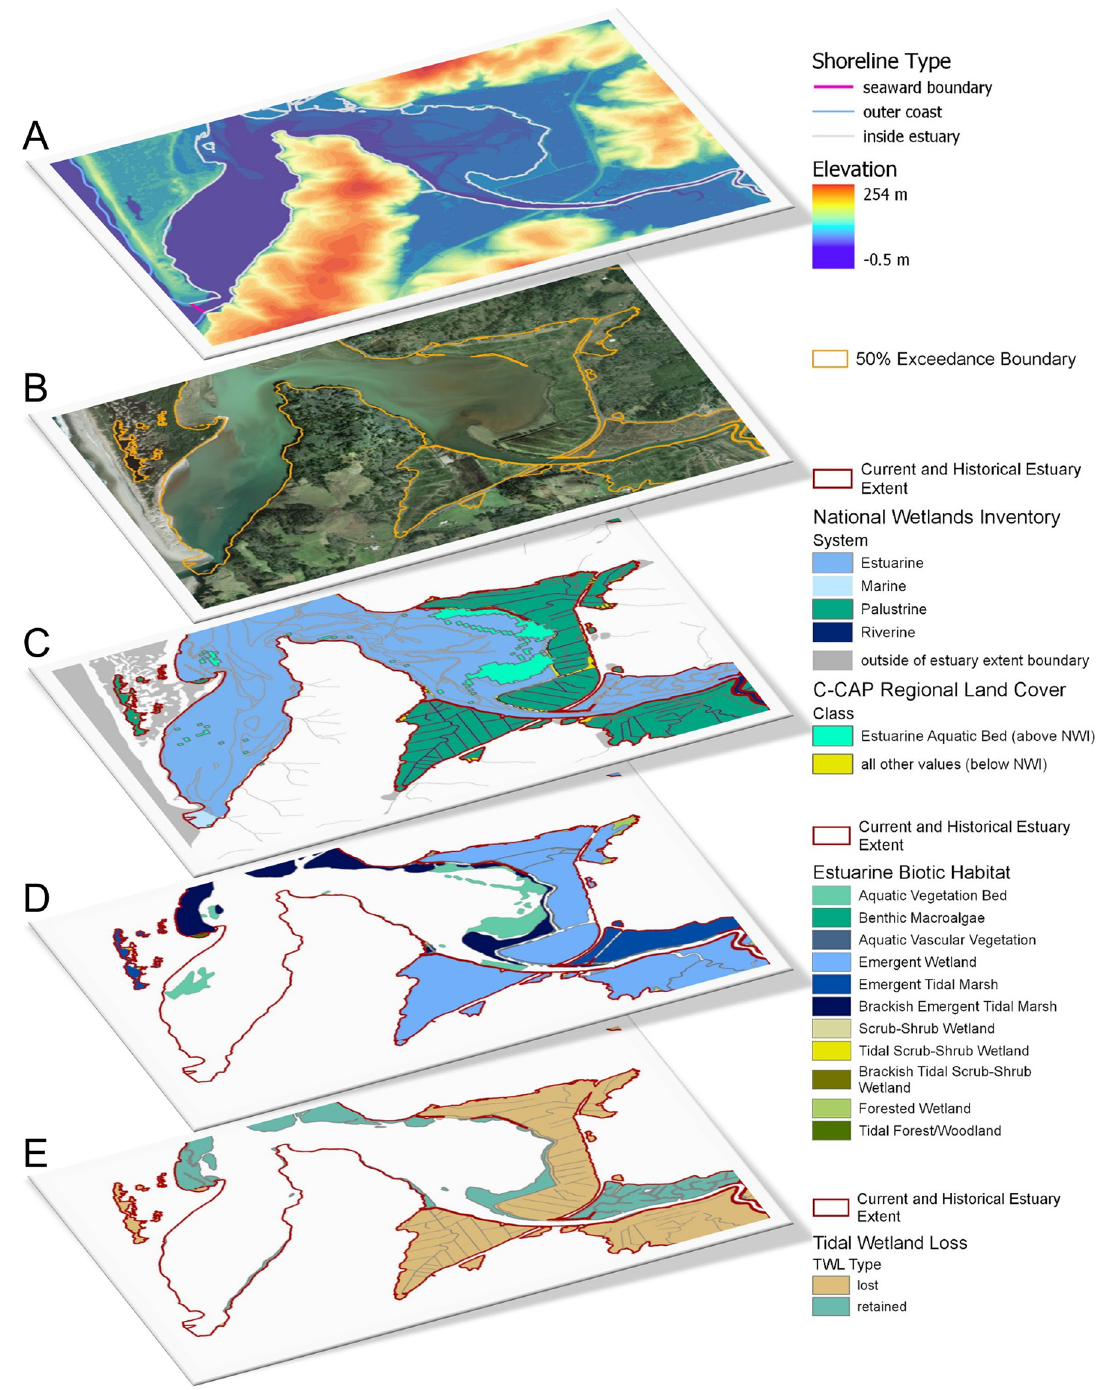
Fig 1. Schematic of data sources used in EBEEM analysis and outlined in Table 1. A) Elevation (topography and bathymetry) from lidar DEM and modified CUSP shoreline data. B) 50% exceedance elevation boundary derived from DEM surface. C) National Wetlands Inventory (NWI) and C-CAP Regional Land Cover data within estuary extent layer. D) West Coast USA Estuarine Biotic Habitat layer derived from NWI and C-CAP. E) Indirect Assessment of West Coast USA Tidal Wetland Loss layer.